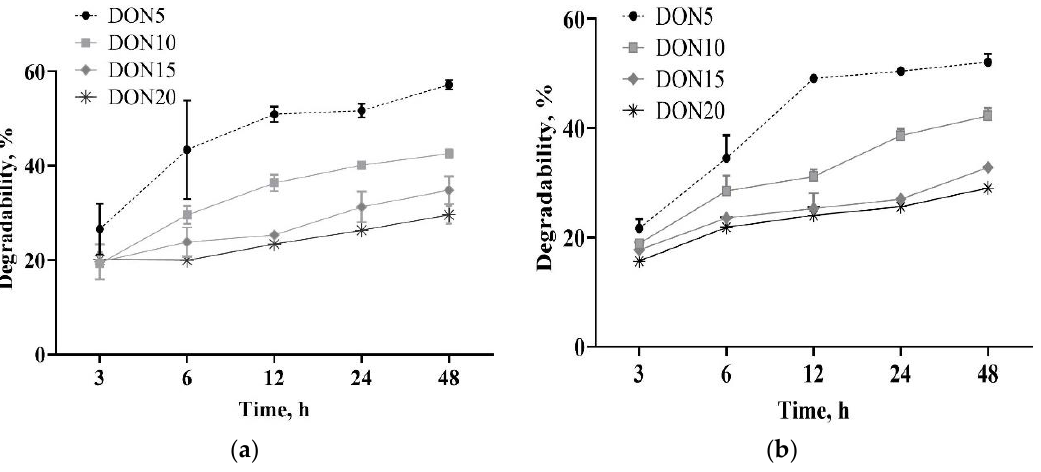
Figure 1. Degradability of DON over time in the presence of HF substrate ( a ) and LF substrate ( b ).